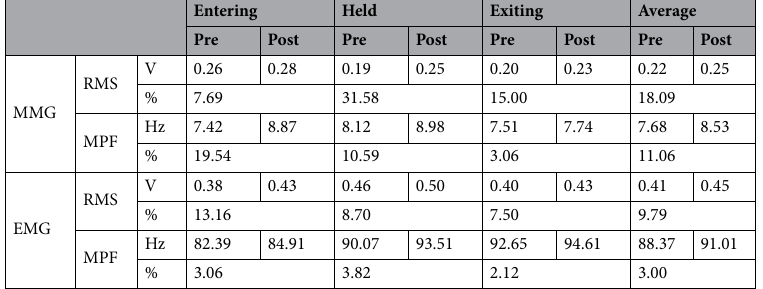
Table 1. Results of before (pre) and after (post) exertion task. Raw values (V/Hz) and percentage change (%) of RMS and MPF between pre and post exertion, in each of the contraction periods for both MMG and EMG, are shown. All results showed no significant difference ( P > 0.05) post